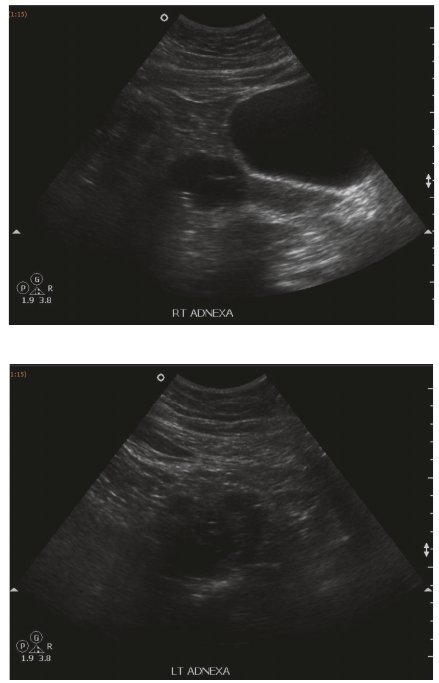
Figure 1: The ultrasound pelvis showed a multicystic avascular structure in the right adnexa measuring 4.5 x 4.3 x 3.3cm. Another multicystic avascular structure was seen in the left adnexa mea- suring 5.4 x 4.4 x 4.1cm. These could possibly represent polycystic ovaries containing multiple cysts.